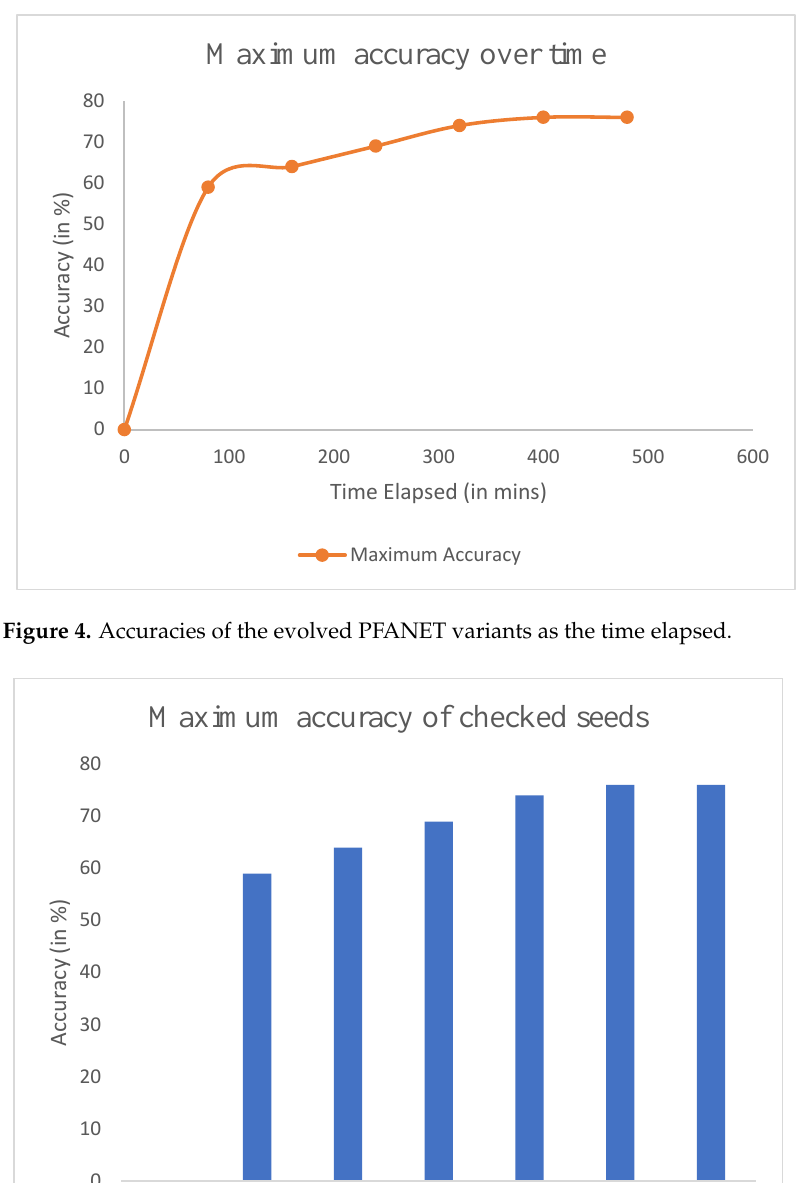
Figure 6. Accuracy change in evolved CNN vs. Default CNN. Table 1 gives an insight into how well the self-designed PFANET fared, when compared to a regular CNN with default hyperparameters. Each network has been compared on the basis of the approximate accuracy gained by each network over time. As is apparent, the best-fit PFANET variant gains more accuracy in shorter time frames, compared to a regular CNN. The key observations that should be made are: •